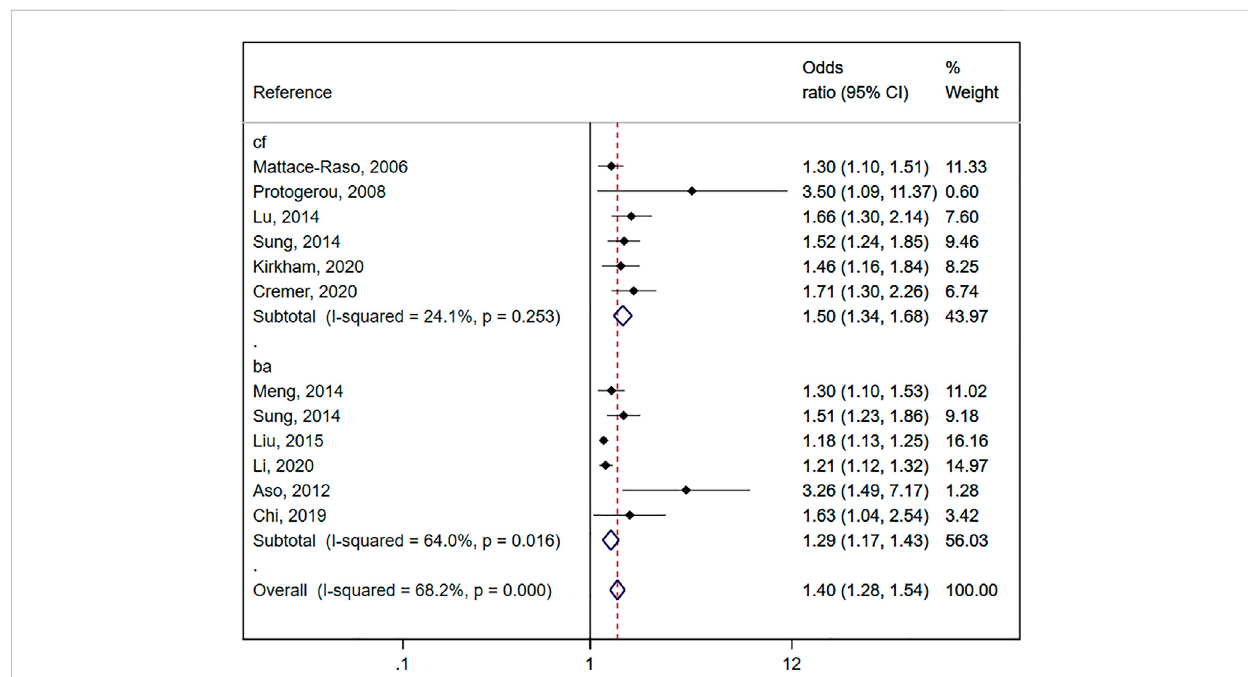
FIGURE 2 Forest plot including the association between orthostatic hypotension and arterial stiffness (central and peripheral pulse wave